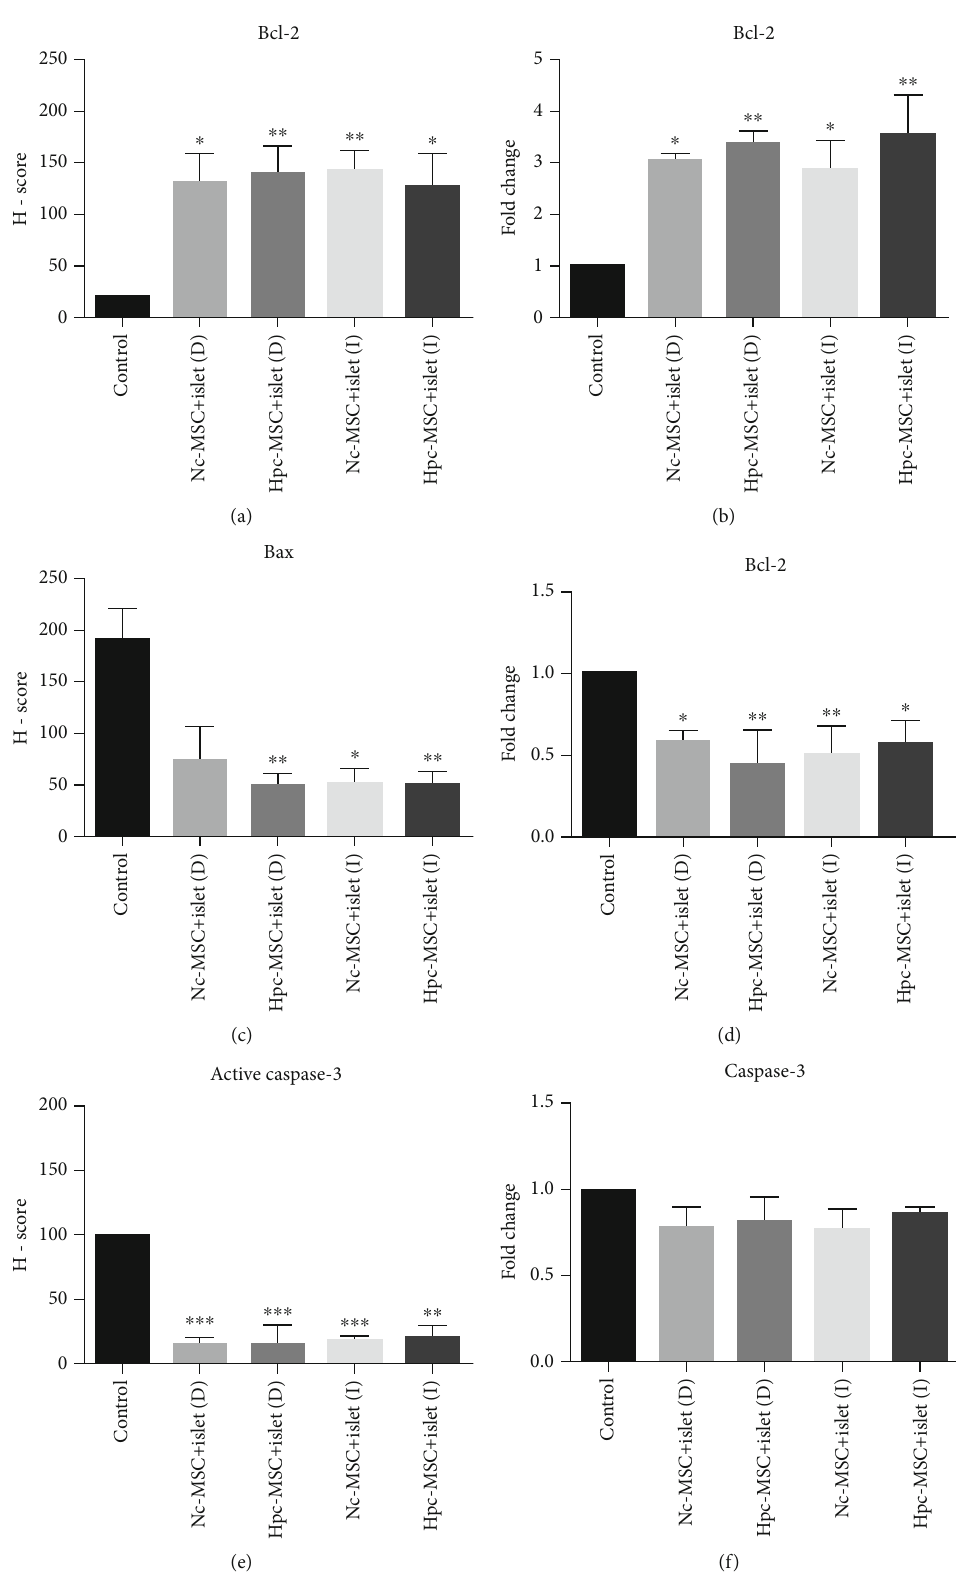
Figure 5: Protein and gene expression of Bcl-2, Bax, and caspase-3 in human islets cocultured with Hpc-MSCs and Nc-MSCs. (a – c) Bax, Bcl- 2, and active caspase-3 protein in the islets expressed as graphs based on the H-score method. (d – f) Bax, Bcl-2, and caspase-3 mRNA expression in the islets. A comparison was done between the control and each cocultured islets. ∗ P < 0 : 05 , ∗∗ P < 0 : 01 , and ∗∗∗ P < 0 : 001 . Nc-MSCs: normoxia condition mesenchymal stem cells; Hpc-MSCs: hypoxia preconditioning MSCs; D: direct coculture; I: indirect